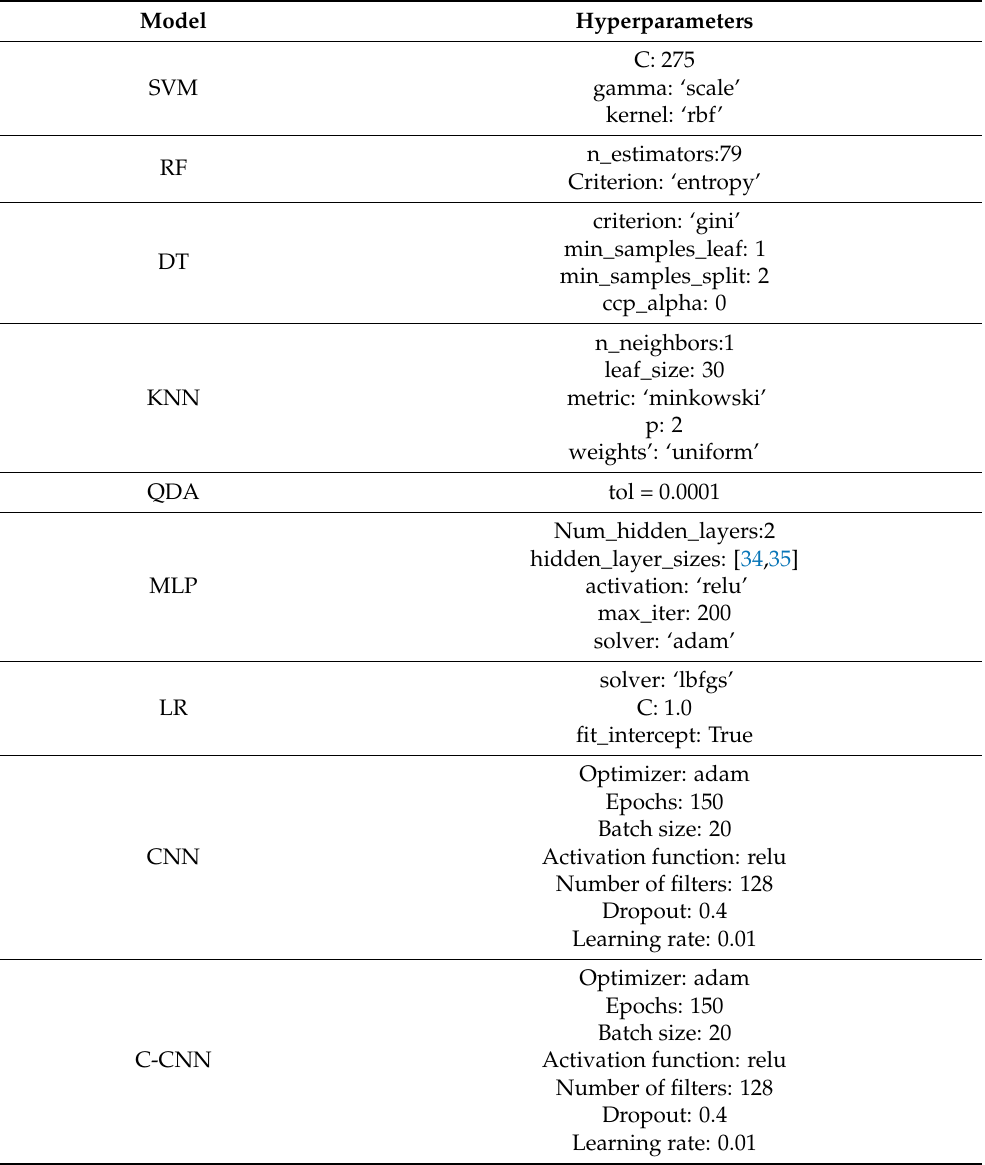
Table 2. Hyperparameters of The Proposed